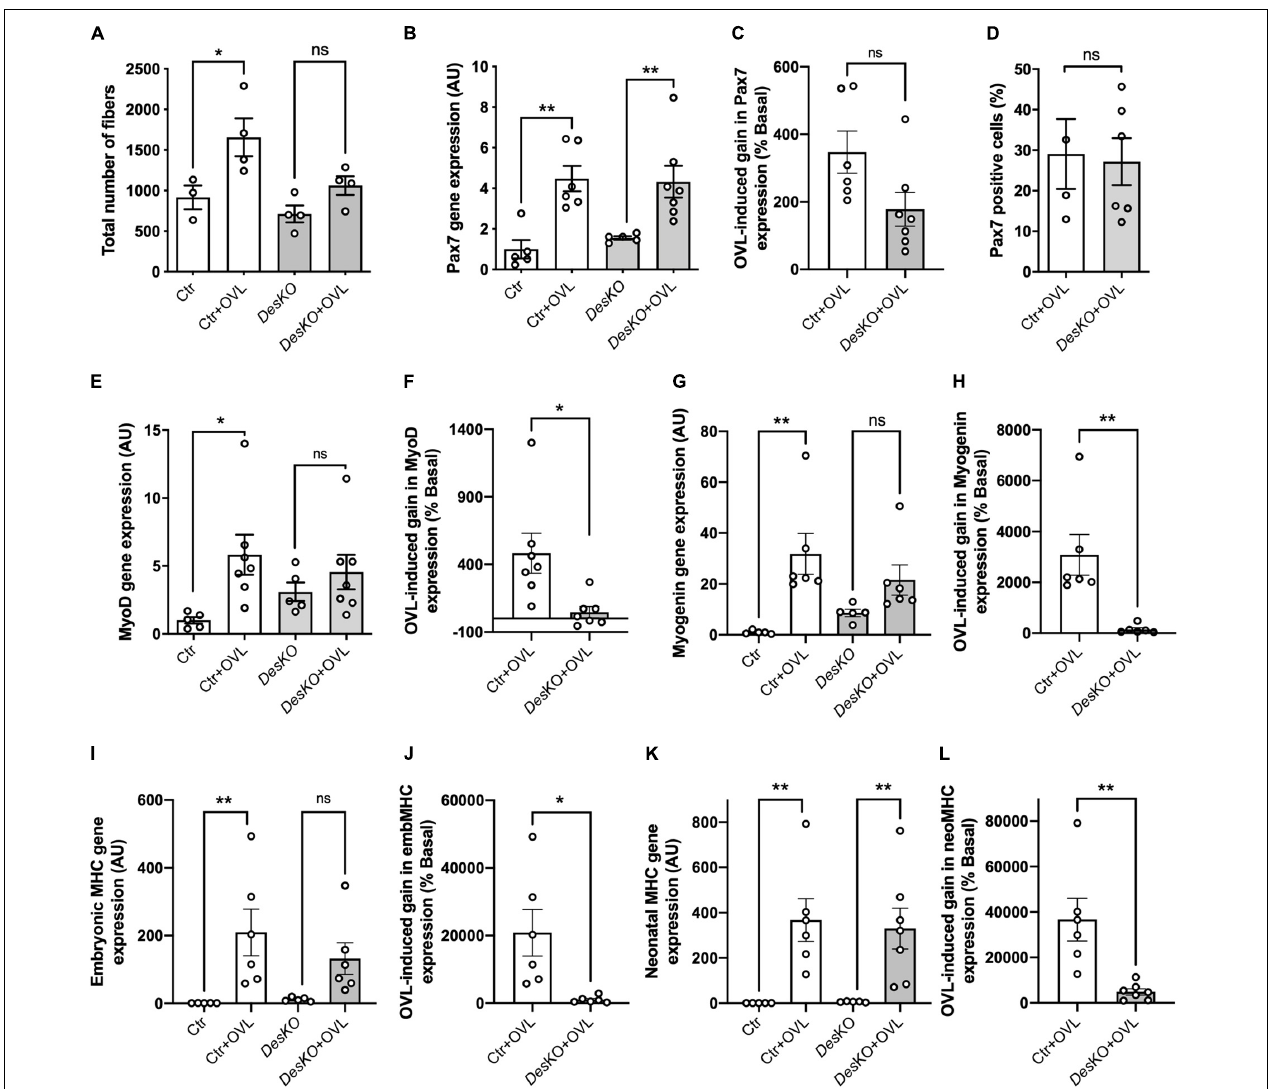
FIGURE 5 | The myogenic program is disturbed in DesKO after OVL. Total number of fibers of plantaris muscle were evaluated after 1 month of OVL (A) . Gene expression analysis for Pax7 (B,C) , MyoD (E,F) , Myogenin (G,H) , embryonic MHC (I,J) and neonatal MHC (K,L) were evaluated in both genotype (Ctr and Des KO) in basal condition or after 7 days of OVL. The gain or loss of expression of these genes was calculated compared to the corresponding basal condition for the Ctr + OVL and Des KO + OVL groups (C,F,H,J,L) . Moreover, Pax7 positive cells were counted after 7 days of OVL (D) . Data are given as means ± SEM. Des KO, Desmin knock-out mice; Ctr, Control mice; OVL, mechanical overloading; MHC, myosin heavy chain. ns : non-significant, * p < 0.05, ** p <